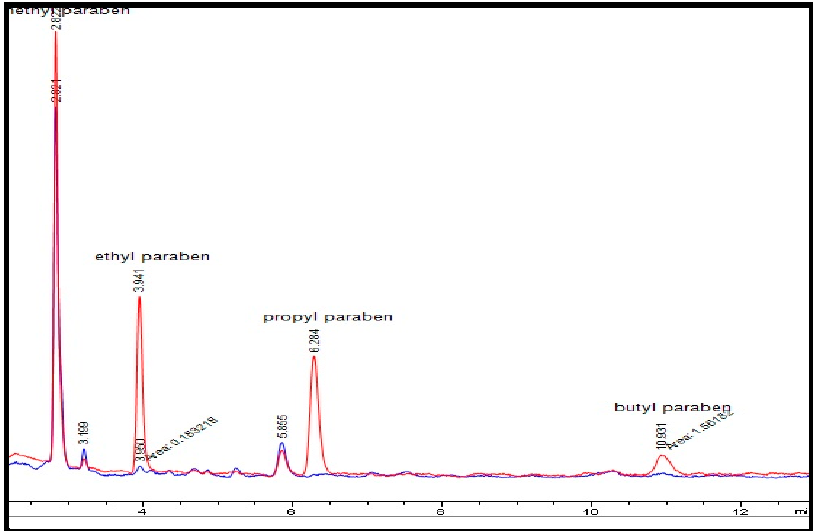
Figure 4. Chromatogram related to the extraction of target analytes (blue) wastewater (red) spiked wastewater at concentration level of 150 µg·L − 1 of analytes.